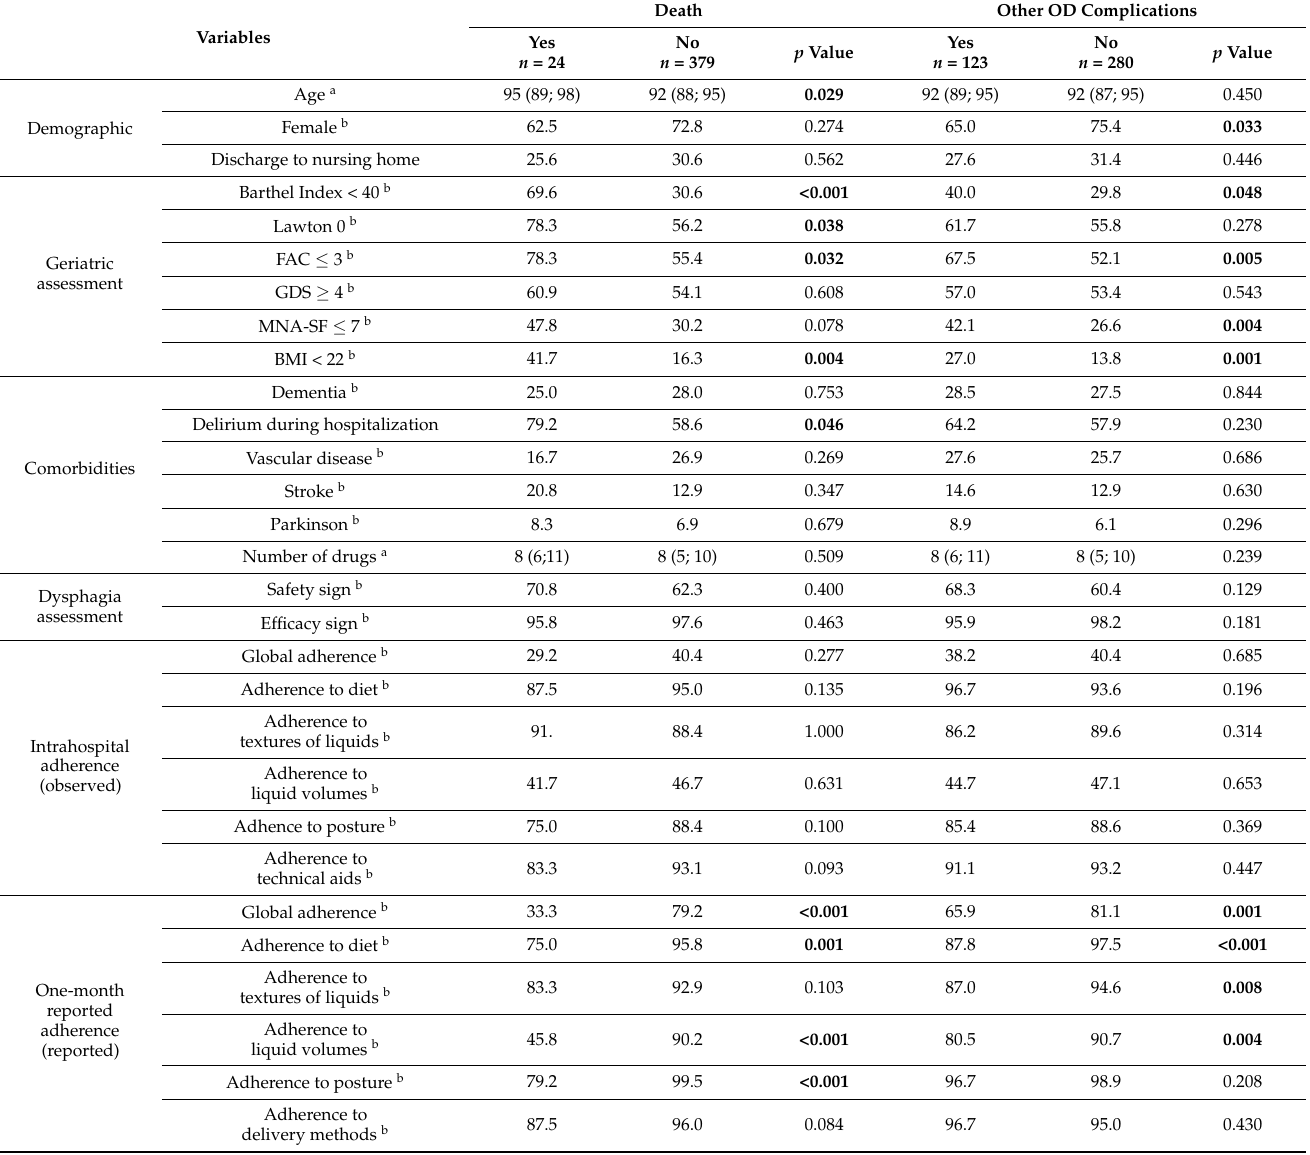
Table 3. Demographic characteristics and clinical data according to mortality or one-month complica- tions in the univariate